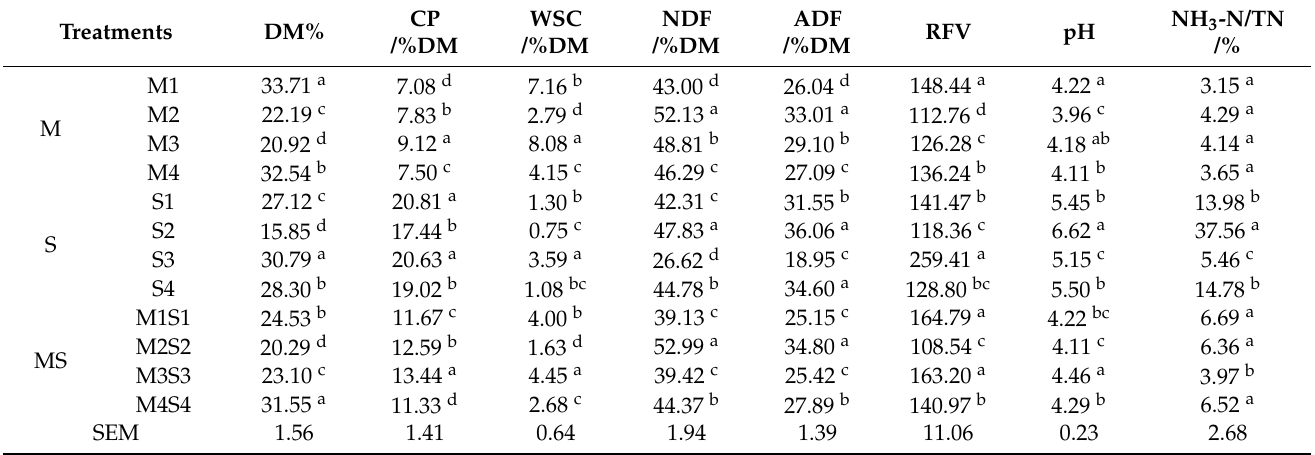
Table 5. Effects of maize varieties on the silage quality of maize–soybean intercropping.